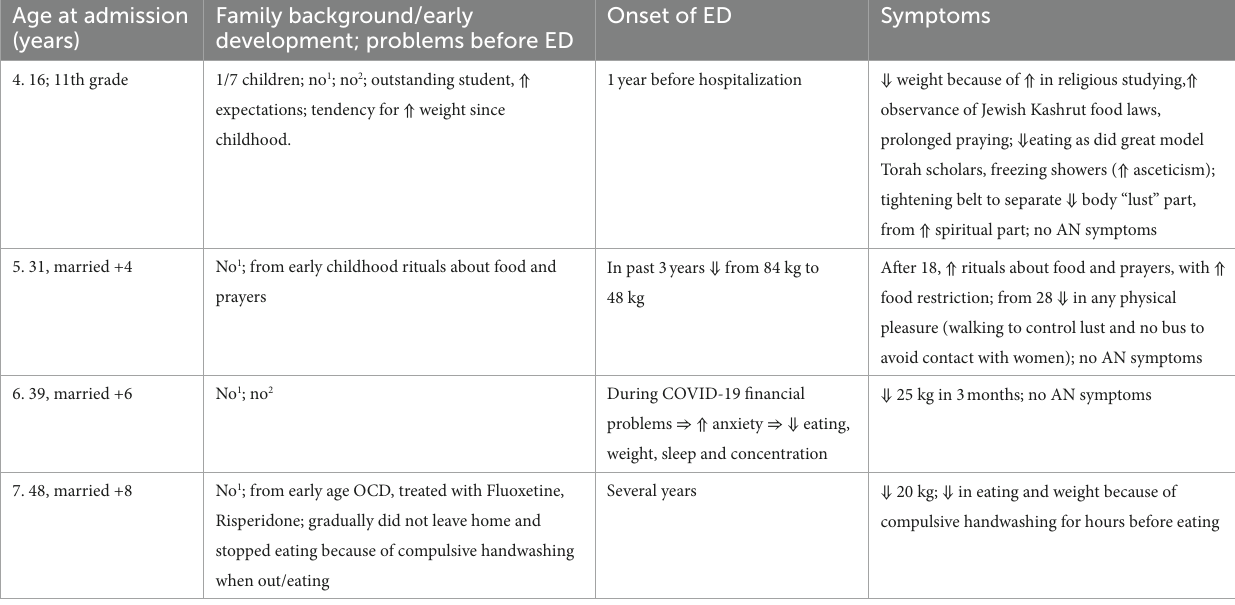
TABLE 3 One adolescent and three adults with DSM 5-TR unspecified restricting-type eating disorder resulting from OCD; pre-hospitalization